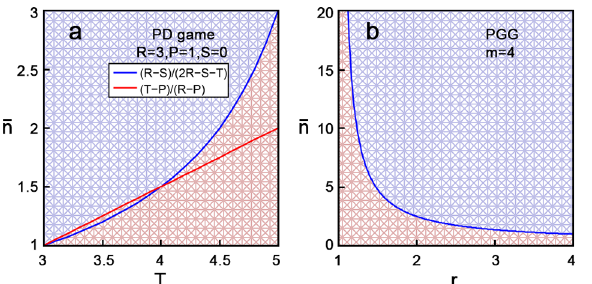
Fig 1. Evolutionary stabilities for TFT in the repeated PD game and the repeated PGG. (a) PD game with payoffs R = 3, P = 1, S = 0 and 3 < T < 5. A TFT population can prevent the invasion of any non- cooperative strategy if (cid:1) n > max fð T (cid:3) P Þ = ð R (cid:3) P Þ ; ð R (cid:3) S Þ = ð 2 R (cid:3) S (cid:3) T Þg (the blue region). (b) 4-person PGG with 1 < r < 4. A TFT population can prevent the invasion of any non-cooperative strategy if (cid:1) n is above the blue curve (the blue